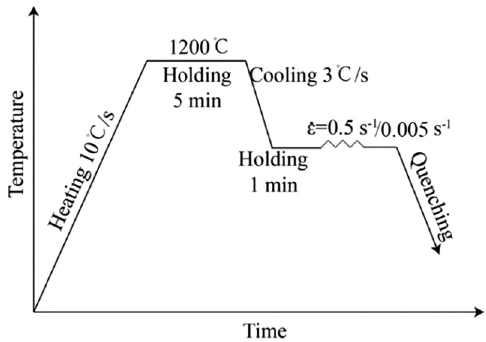
Figure 1: The thermal schedule of hot tensile straining.